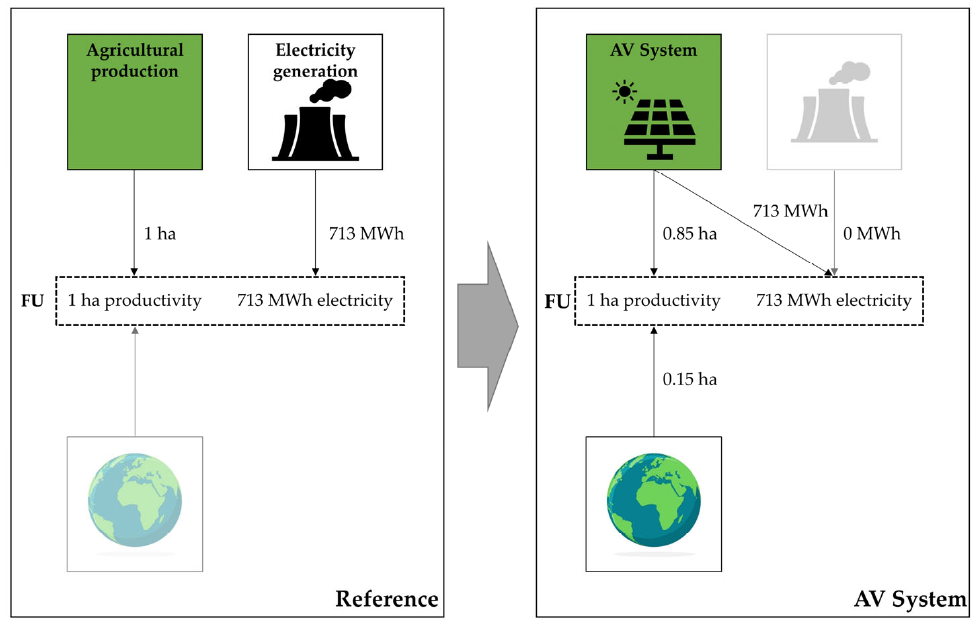
Figure 1. System boundaries for the AVS and the reference system which will be replaced. Through the combination of energy generation and agricultural cultivation in the AVS, considerably less land is needed compared to the separate production of crops and energy [13,30]. Hence, it is hypothesised that more land becomes available due